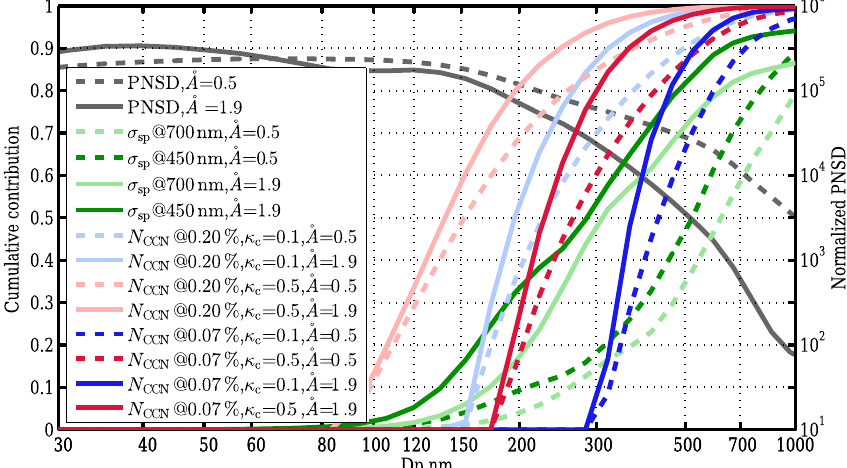
Figure 1. Aerosol PNSD (black lines), the cumulative contribution of σ sp at wavelength of 450 and 700nm (dark green lines and light green lines, respectively), the cumulative contribution of N CCN at a supersaturation of 0.07% (dark red and dark blue lines) and the cumulative contribution of N CCN at a supersaturation of 0.20% (light red and light blue lines) based on measurement in several campaigns in the North China Plain. Solid lines and dashed lines indicate Å of 1.9 and 0.5, respectively. Blue lines and red lines indicate κ c of 0.1 and 0.5,